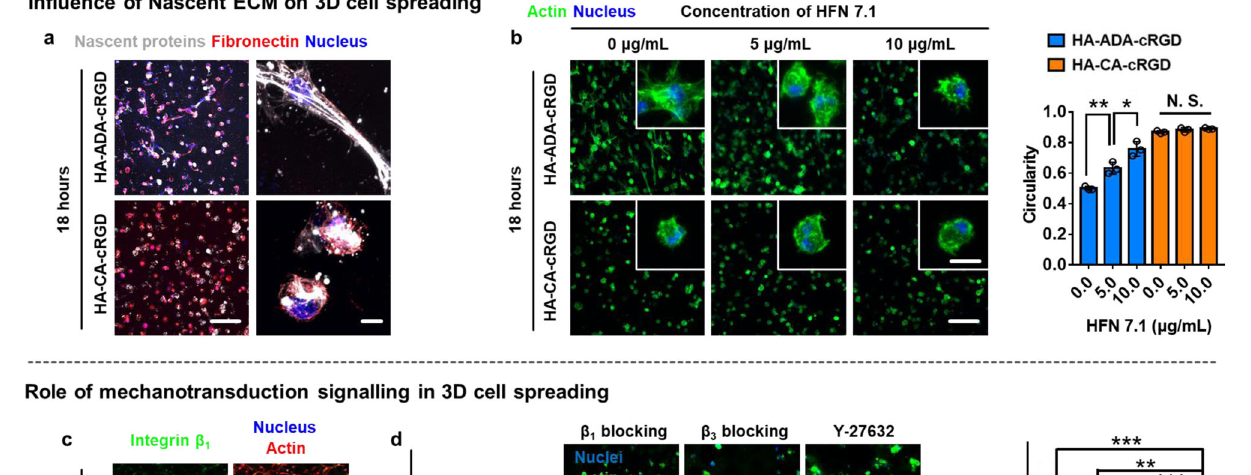
Fig. 6 The ultra-rapid cell spreading and aggregation in HA – ADA – cRGD hydrogels is regulated by cell – nascent ECM interaction, cell adhesion structures containing β 1 class integrins, and actomyosin-based contractility. a Representative images (magni fi cations on the right) of nascent proteins (white) and fi bronectin (red) secreted by hMSCs encapsulated in HA – ADA – cRGD and HA – CA – cRGD gels within 18 h (scale bars, 200 µ m (pictures on the left) and 20 μ m (pictures on the right)). b Representative images (scale bars, 200 µ m (main image) and 10 µ m (inset)) of F-actin (green) expressed by the